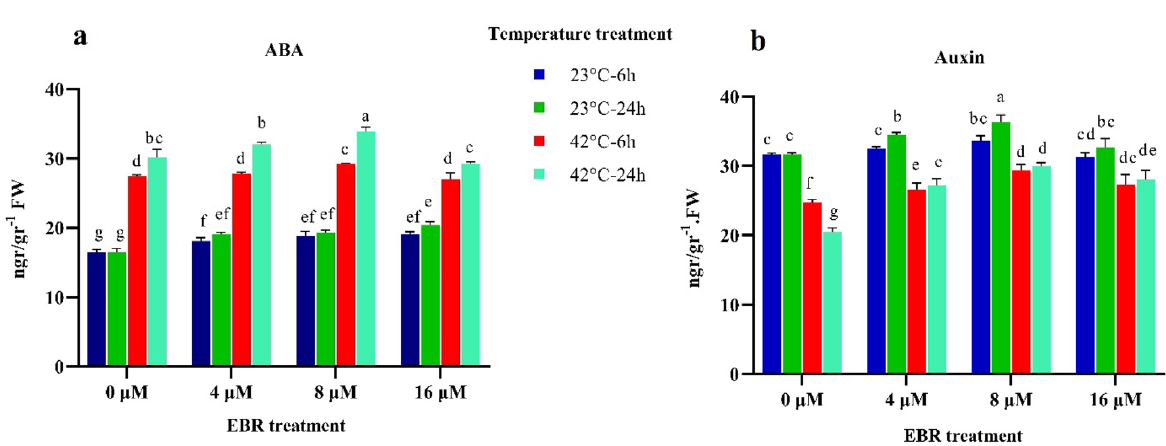
Figure 5. The effects of temperature, harvesting times, and different levels of EBR on Abscisic acid ( a ) and Auxin content ( b ). Duncan method at a 1% probability level was applied to compare mean values. The columns having similar letters had no significant